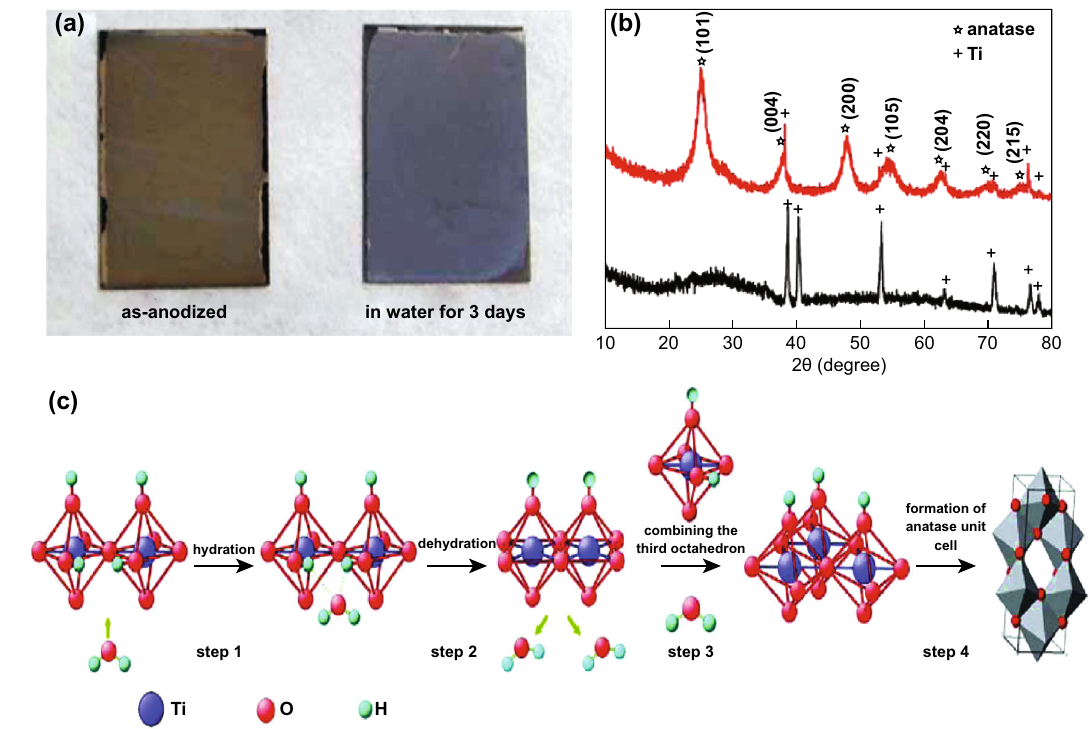
Fig. 3 a Digital photographs showing the appearance change of a TiO 2 NT/Ti film before and after the treatment. b XRD patterns demonstrating the phase transformation before (black line) and after (red line) the water soaking for the TiO 2 NT/Ti film. c Schematic showing the nucleation of anatase from amorphous TiO 2 induced by water [40]. Copyright (cid:2) 2011 American Chemical Society. (Color figure